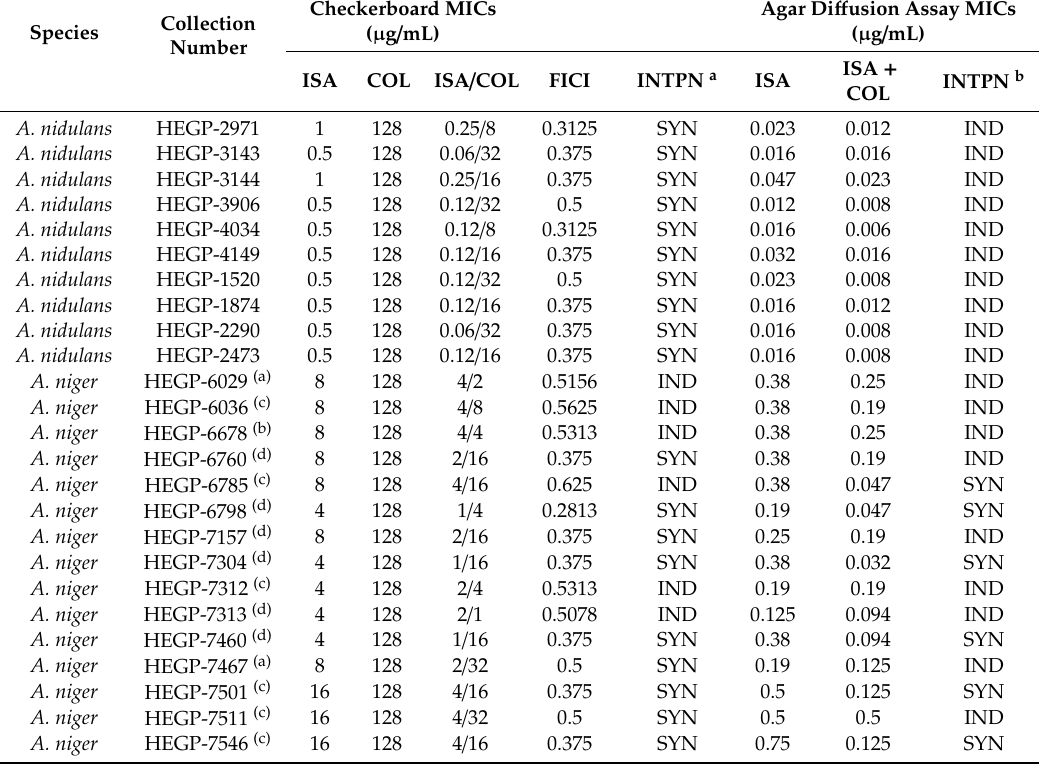
Table 2. In vitro combination of isavuconazole with colistin against Aspergillus nidulans and Aspergillus niger isolates using EUCAST broth microdilution checkerboard methodology and agar di ff usion